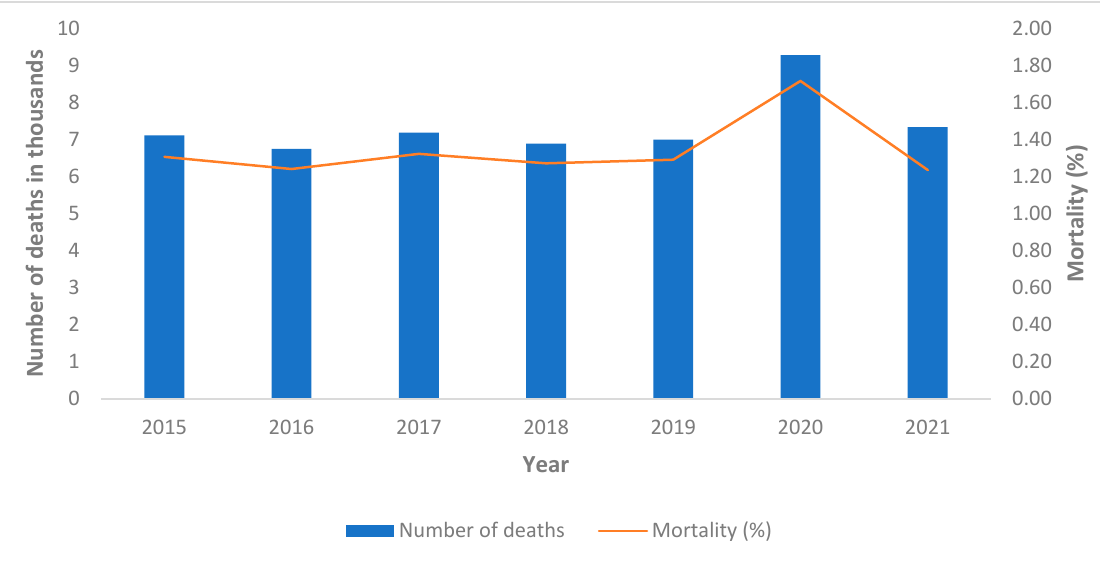
Figure 3. Number of deaths and mortality rate in the population of the province of Pavia (b). While in Italy the mortality rate in 2020 was 1.25% with an increase of 16.37% compared to the previous 5 years, in the province of Pavia the mortality rate in the same year was 1.72% with an increase of 33.43% compared to the previous year (Figures 2 and 3). Mortality of all the physicians and dentists (c) went from 0.49% in the 5 years preceding the epidemic, to 0.83% in 2020 and then dropped to 0.43% in 2021 (Figure 4). Population data cannot be directly compared with those of physicians and dentists because the groups are made up of a population of different